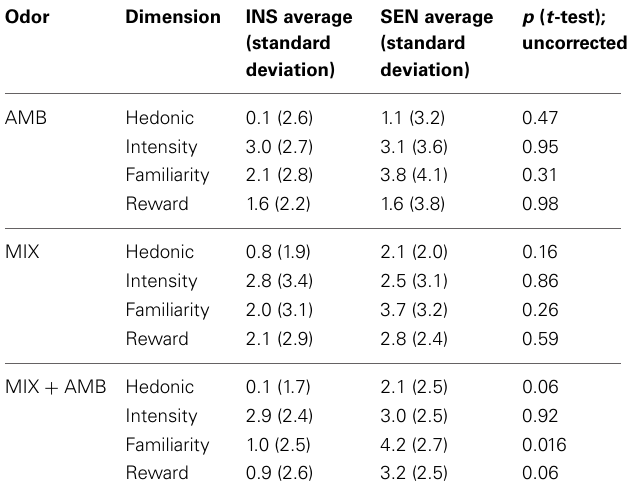
brain regions, such as left insula, bilateral amygdala, and piriform cortex ( Table 2 for summary of brain activations; Figure 2